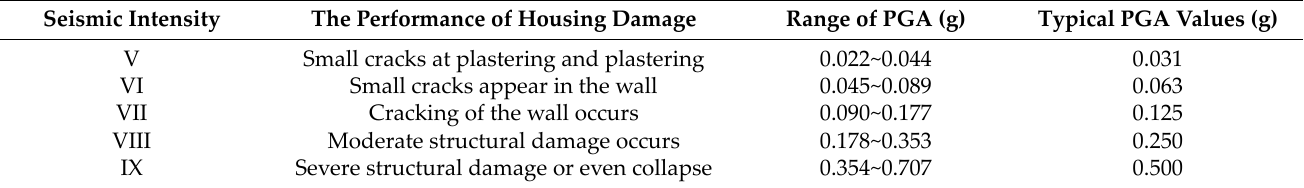
Table 3. Correspondence table between seismic intensity and